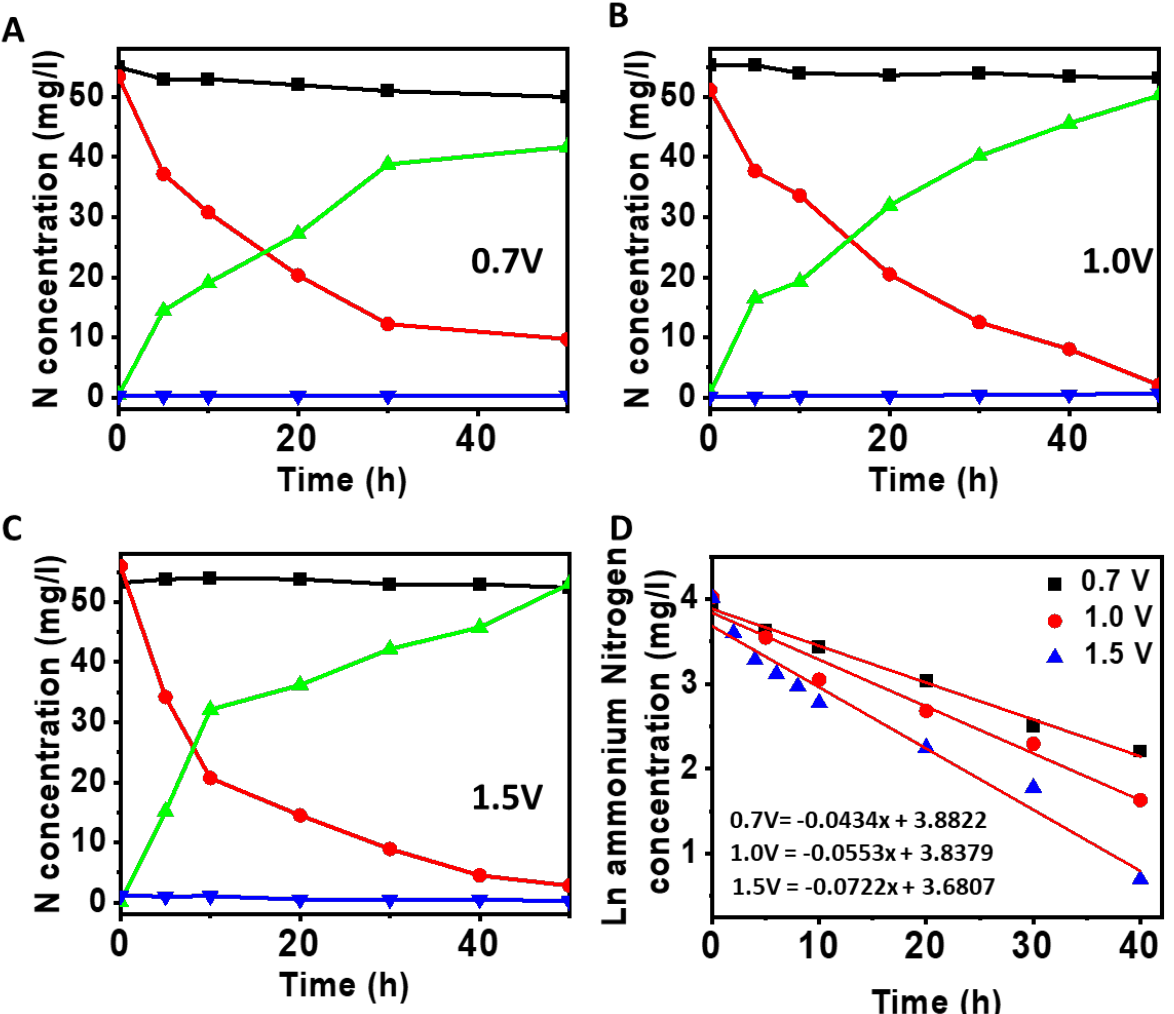
Figure 4. The variation in N concentrations with variation in applied voltage. 0.7 V ( A ), 1.0 V ( B ), and 1.5 V ( C ). The total nitrogen (black squares), ammonium nitrogen (red circles), nitrate nitrogen (green up triangle), and nitrite nitrogen (blue down triangle). The linear regressions ( D ) were noted at different applied voltages (NH 4 -N, initial ammonium nitrogen: 50 mg/L).